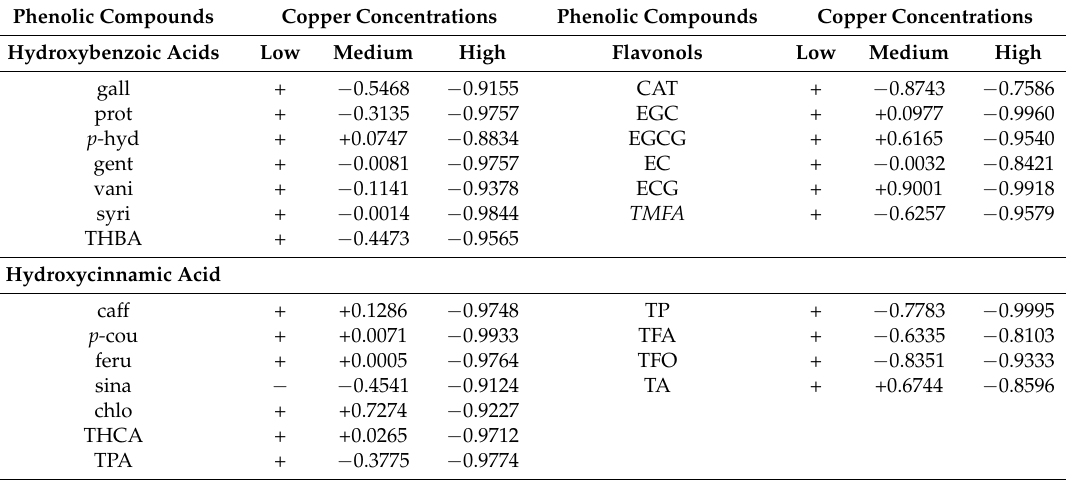
Table 1. Lineal correlation coefficients (R 2 ) between copper concentrations and phenolic compounds of wine. Phenolic Compounds Copper Concentrations Phenolic Compounds Copper Concentrations Hydroxybenzoic Acids Low Medium High Flavonols Low Medium High gall + − 0.5468 − 0.9155 CAT EC